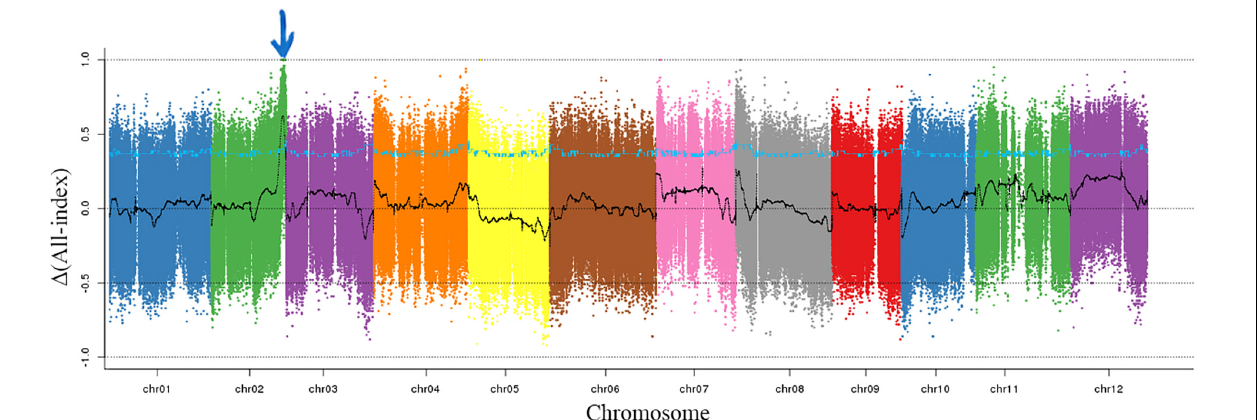
FIGURE 4 | (cid:49) (All-index) graphs from BSA-seq. The (cid:49) (all-index) was calculated at a 1-Mb intervals with a 50-kb sliding window. One candidate region was identified on chromosome 2 indicating with the blue arrow.